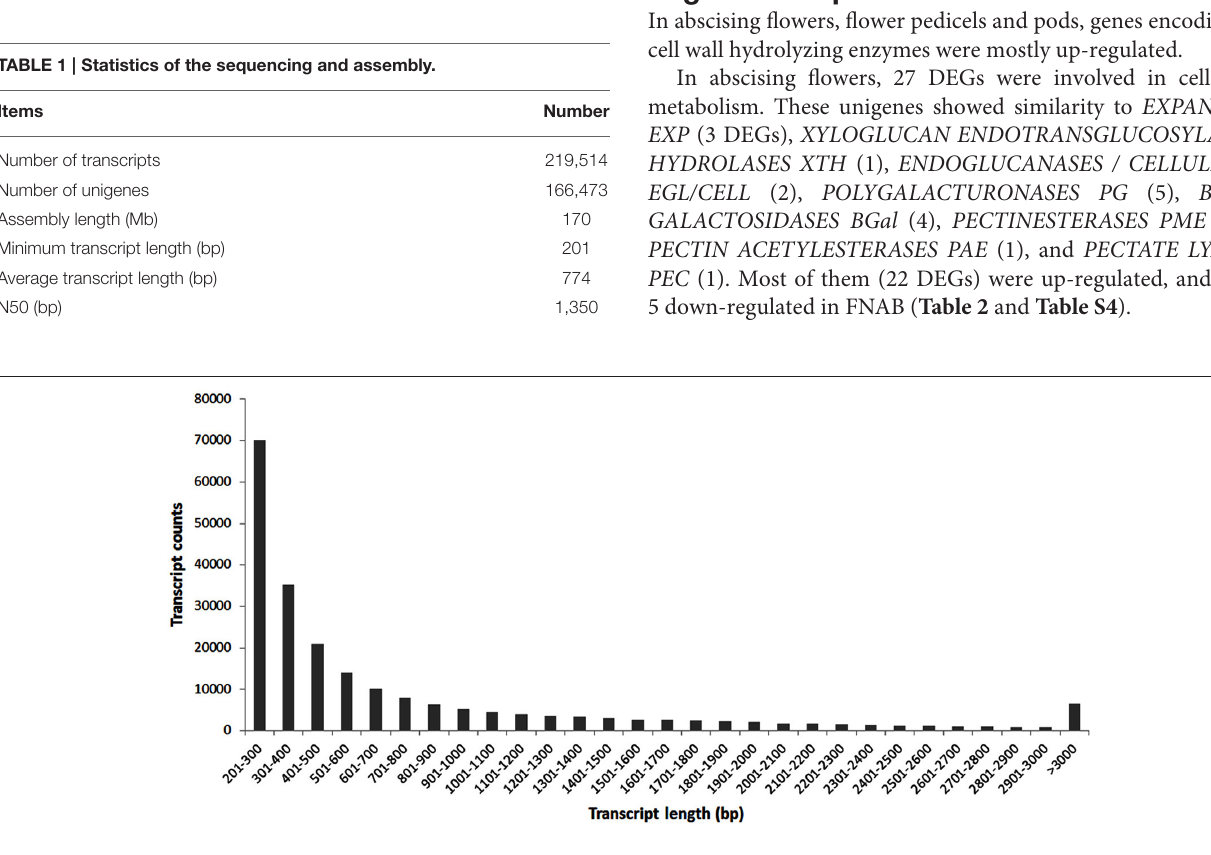
FIGURE 3 | The length distribution of the assembled